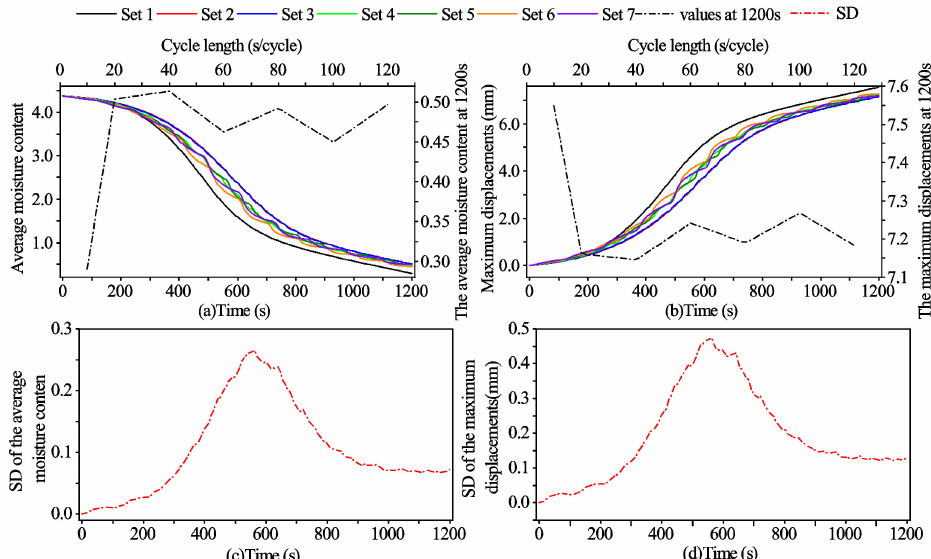
Figure 12. The moisture contents and displacements of different settings. ( a ) Average moisture contents of different settings and at 1200 s. ( b ) Maximum displacements of different settings and at 1200 s. ( c ) The standard deviation of the average moisture content of different settings. ( d ) The standard deviation of the maximum displacements of different